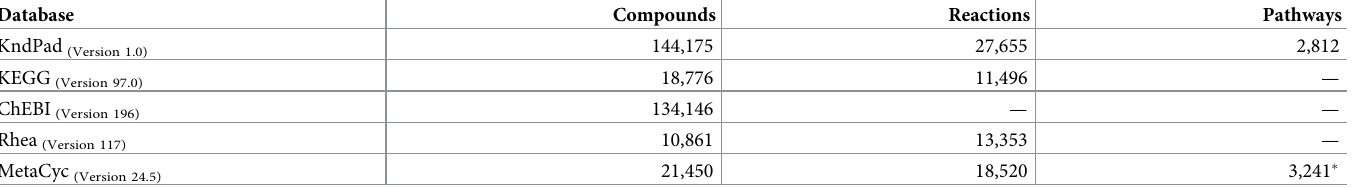
Table 2. Statistical information of compounds, reactions and metabolic pathways in major biochemical databases. Database Compounds Reactions Pathways